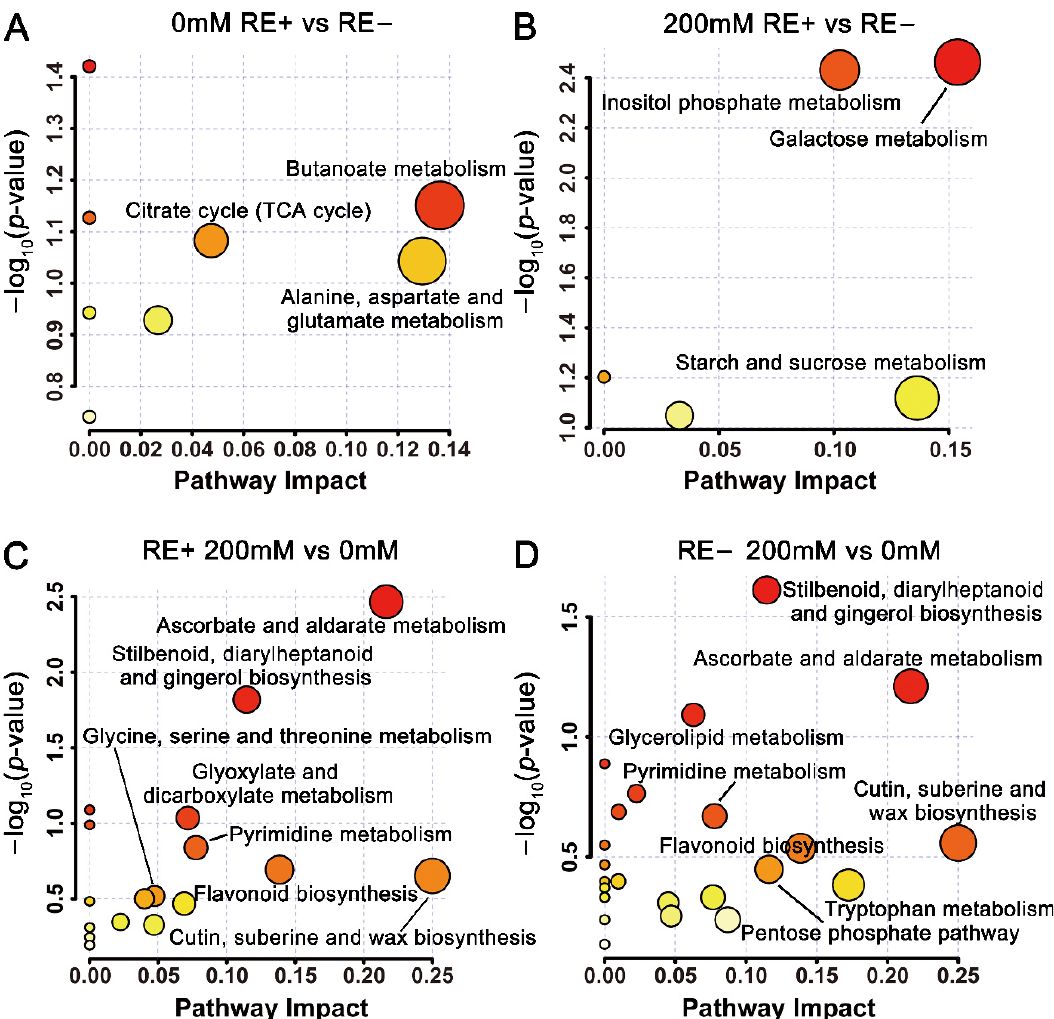
Figure 7. Bubble plots showing the enrichment analysis of altered metabolic pathways in roots. ( A , B ) represent the differential pathways between RE+ and RE − under 0 mM and 200 mM NaCl concentrations, respectively. ( C , D ) represent the differential pathways between 200 mM and 0 mM NaCl treatment in RE+ and RE-, respectively. The plots were organized by pathway enrichment analysis (log 10 ( p -values)) and pathway topology analysis (pathway